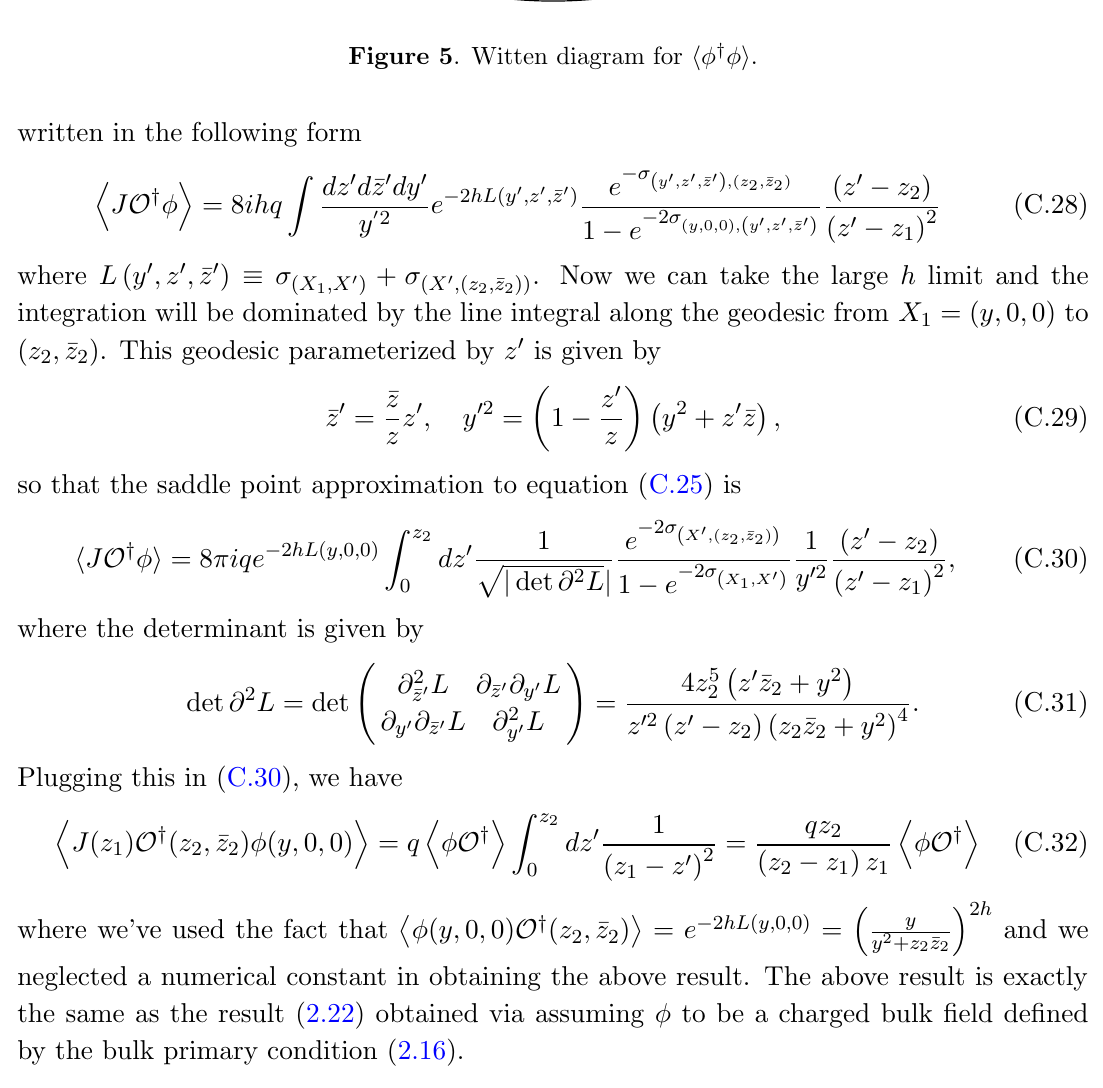
Figure 5 . Witten diagram for